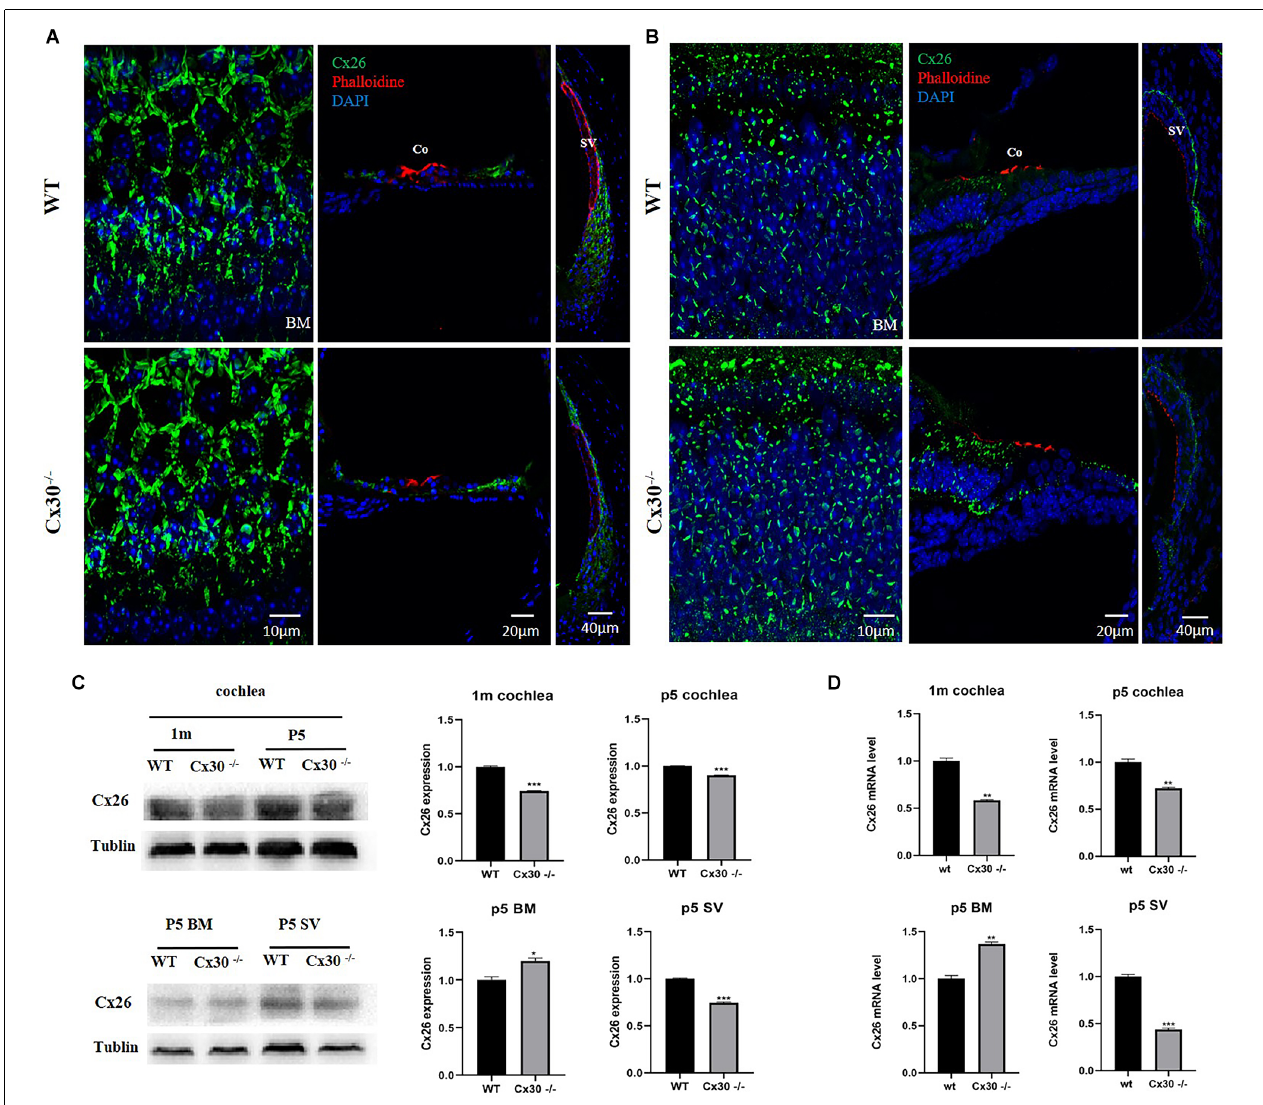
FIGURE 4 | Cx26 expression in Cx30 -/- mice. (A) Immunofluorescence analysis of frozen sections and BM in the cochlea of 1-month-old mouse. (B) Immunofluorescence analysis of frozen sections and BM in the cochlea at P5. Both in 1-month-old and P5, Cx26 expression in the BM of Cx30 -/- mice was stronger than that of WT mice, and Cx26 expression in the vascular stripe of Cx30 -/- mice was significantly lower than that of WT mice. Cx26: Green, Phalloidin: Red, DAPI: Blue (for cell nuclei); scale bar: 10 µ m, 20 µ m, 40 µ m. (C) Western blot analysis of the cochlea, BM, and SV in 1-month-old and P5 mice. Whole cochlear Cx26 protein levels in 1-month-old Cx30 -/- mice showed a 25.9% decrease compared with WT mice; whole cochlear Cx26 protein levels of Cx30 -/- mice showed 9.84% reduction compared with WT mice at P5; cochlear BM Cx26 protein levels of Cx30 -/- mice increased by 19.8% compared with WT mice at P5; Cx26 protein level in SV of the cochlea in Cx30 -/- mice decreased by 25.6% compared with WT mice in P5. (D) qPCR analysis of the cochlea, BM, and SV in 1-month-old and P5 mice. Whole cochlear Cx26 mRNA levels of 1-month-old Cx30 -/- mice declined by 41.8% compared with WT mice; whole cochlear mRNA levels of Cx30 -/- mice decreased by 28% compared with WT mice at P5; cochlear BM Cx26 mRNA levels in Cx30 -/- mice increased by 36.7% compared with WT mice at P5; cochlear SV Cx26 mRNA levels in Cx30 -/- mice reduced by 56.6% compared with WT mice at P5. Data presented as Mean ± SEM. t -test. * p < 0.05, ** p < 0.01, *** p < 0.001. BM, basemental membrane; SV, stria vascularis; Co, Corti’s